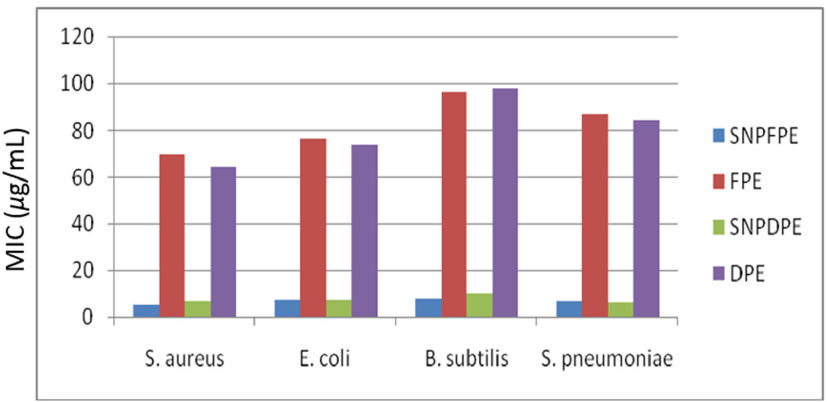
Figure 8. Comparison of the antimicrobial potential of the prepared SNPs with the parent plant extract.